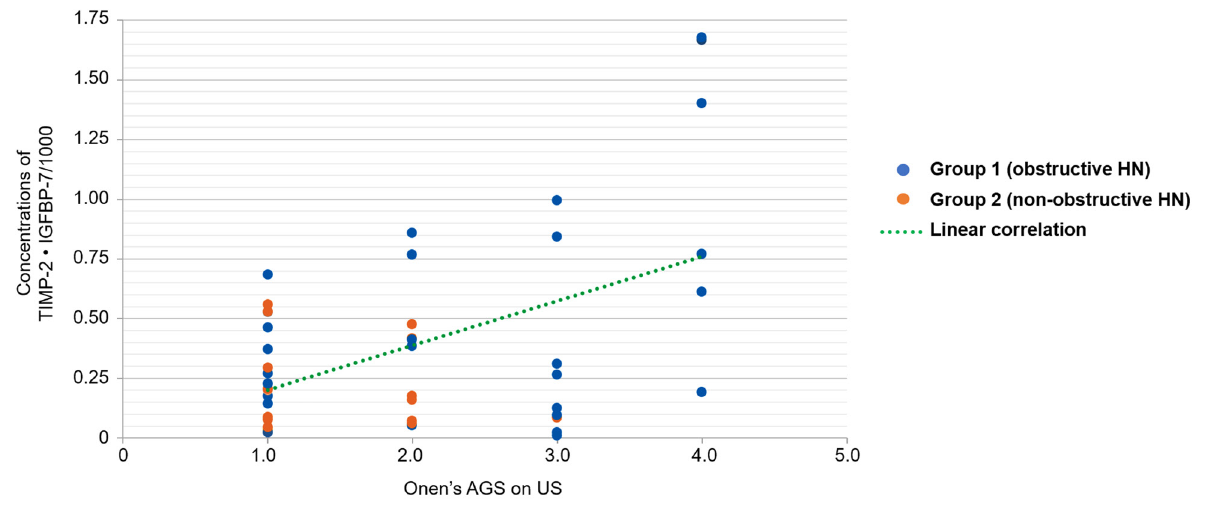
IGFBP-7/1000 and Onen’s alternative grading score on patients with HN. Indicating a trend of linear correlation between degree of hydronephrosis and concentration of TIMP-2 •